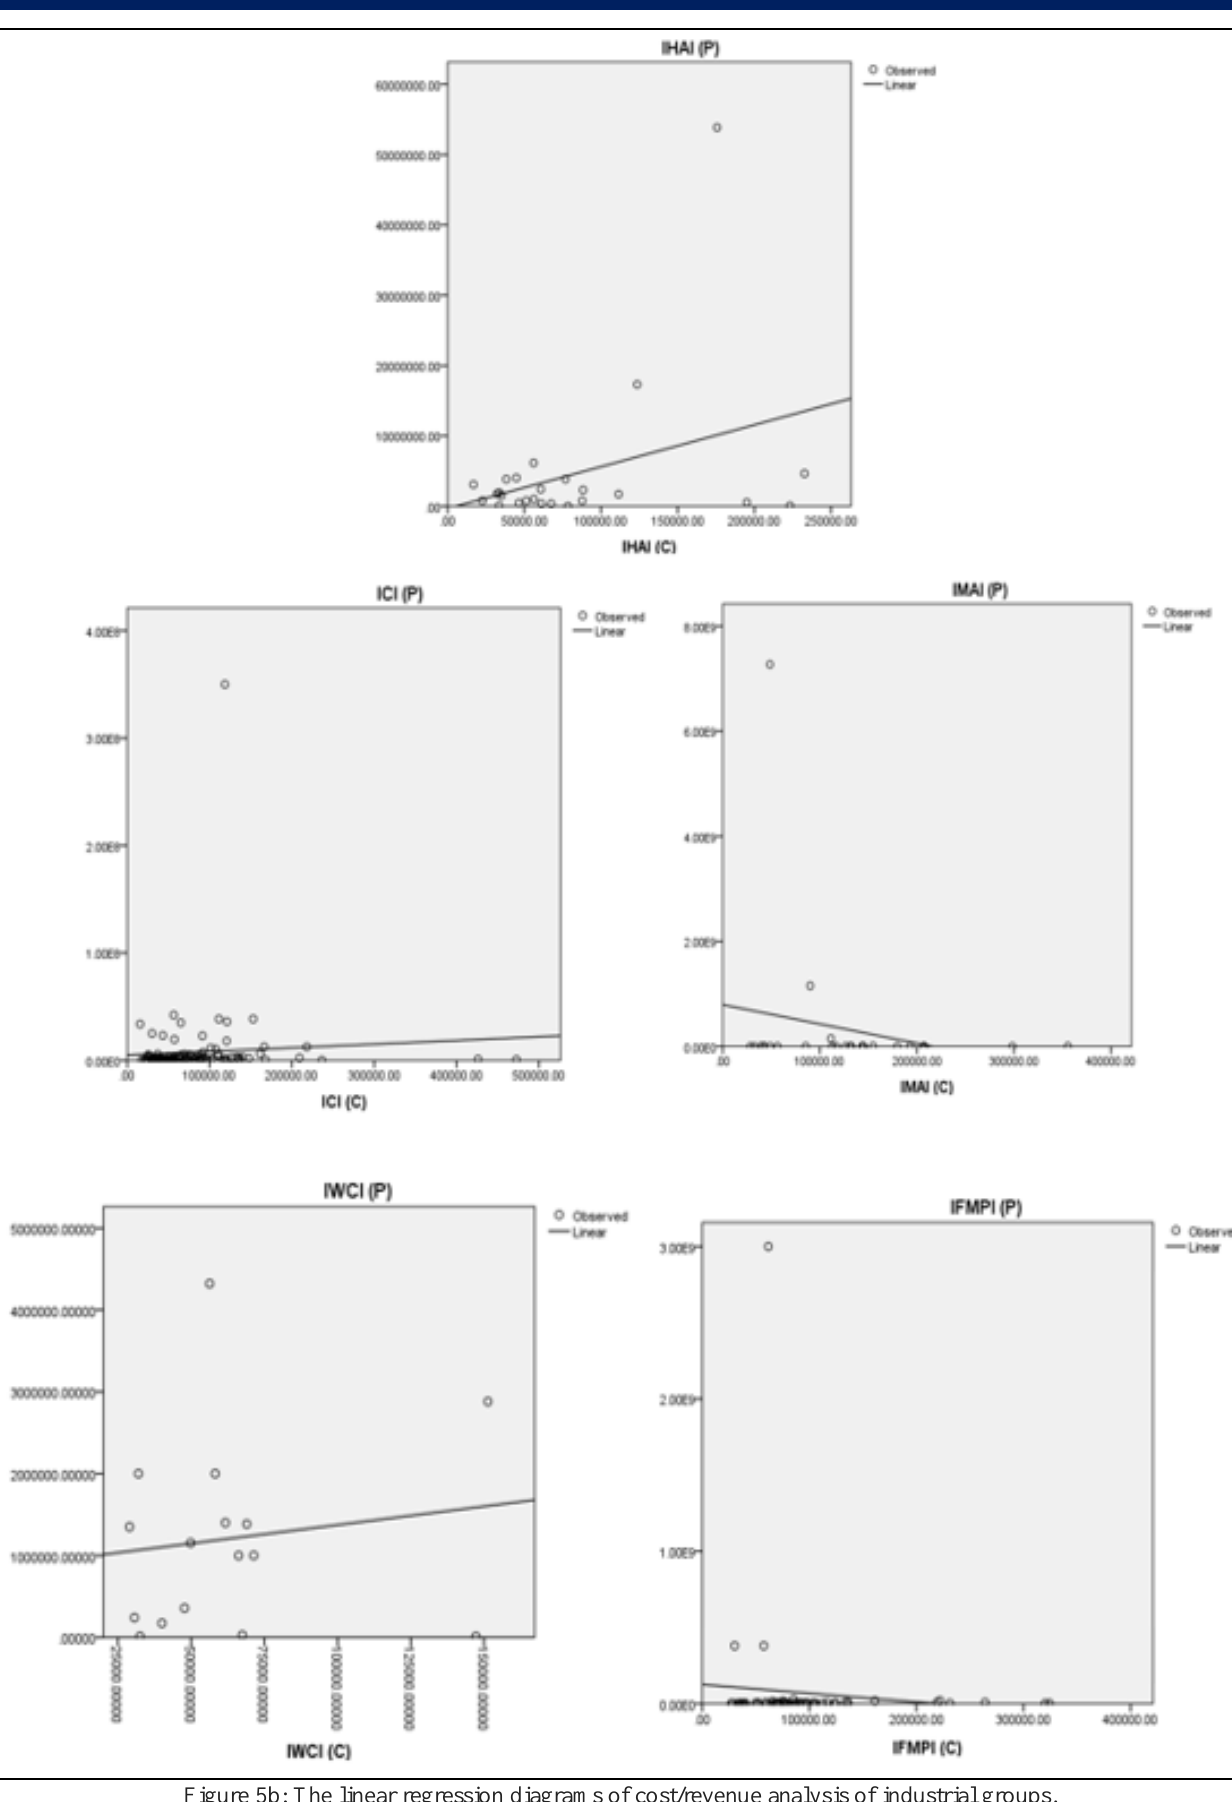
Figure 5b: The linear regression diagrams of cost/revenue analysis of industrial